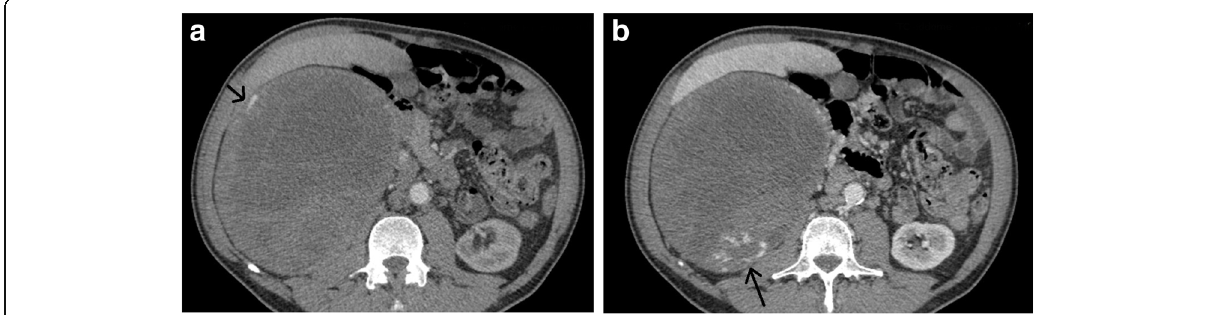
Fig. 2 a , b CT with contrast revealed a well-defined expansive lesion in the right adrenal lodge, with inhomogeneous density. It showed enhancement in arterial ( a ) and venous ( b ) phase, with peripheral vascular lacunae (marked with the